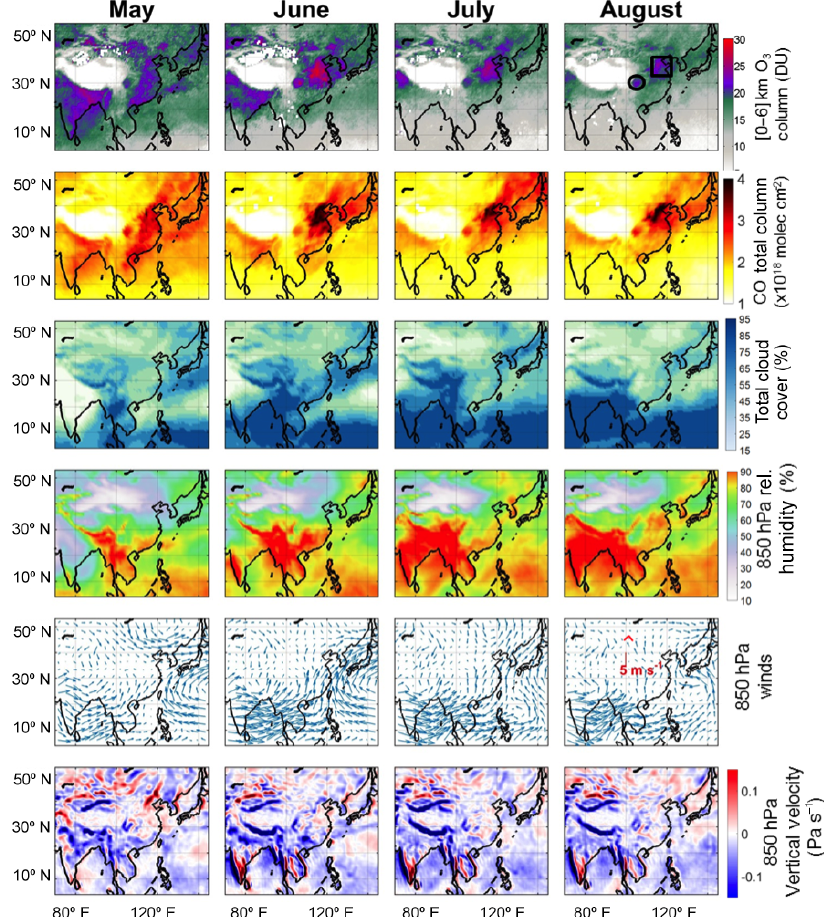
Figure 2. Monthly averaged tropospheric 0–6km O 3 column from IASI, CO total columns from IASI, along with ECMWF total cloud cover, relative humidity, horizontal and vertical winds at 850hPa for each of the months of May to August 2011. The black square and circle (upper right plot) are the regions the least affected by the EASM and discussed more in the